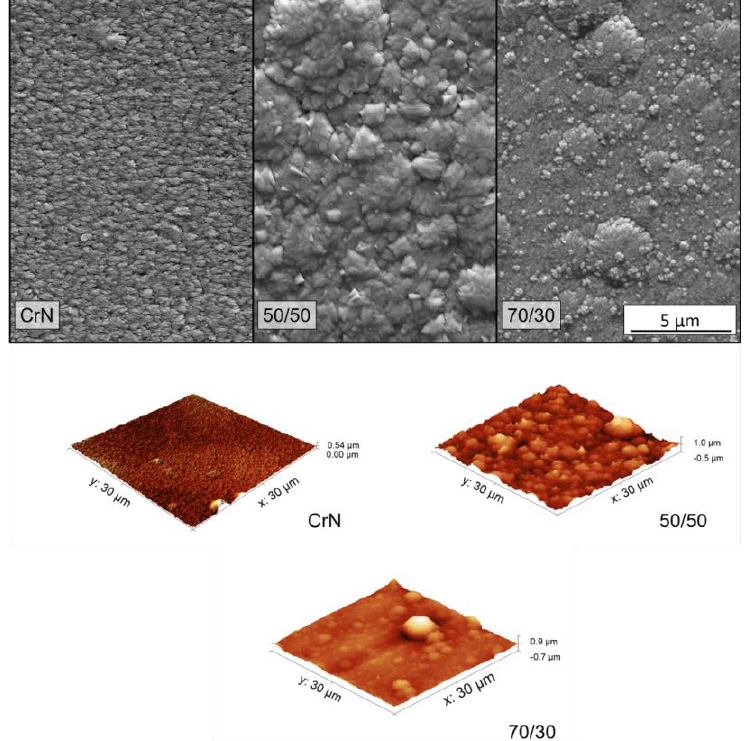
Figure 6. SEM images top view and atomic force microscopy (AFM) surface mapping of the Cr–Al– N ceramic coatings. All images are in the same scale. Table 2. Values of mean arithmetic roughness and H 3 /Er 2